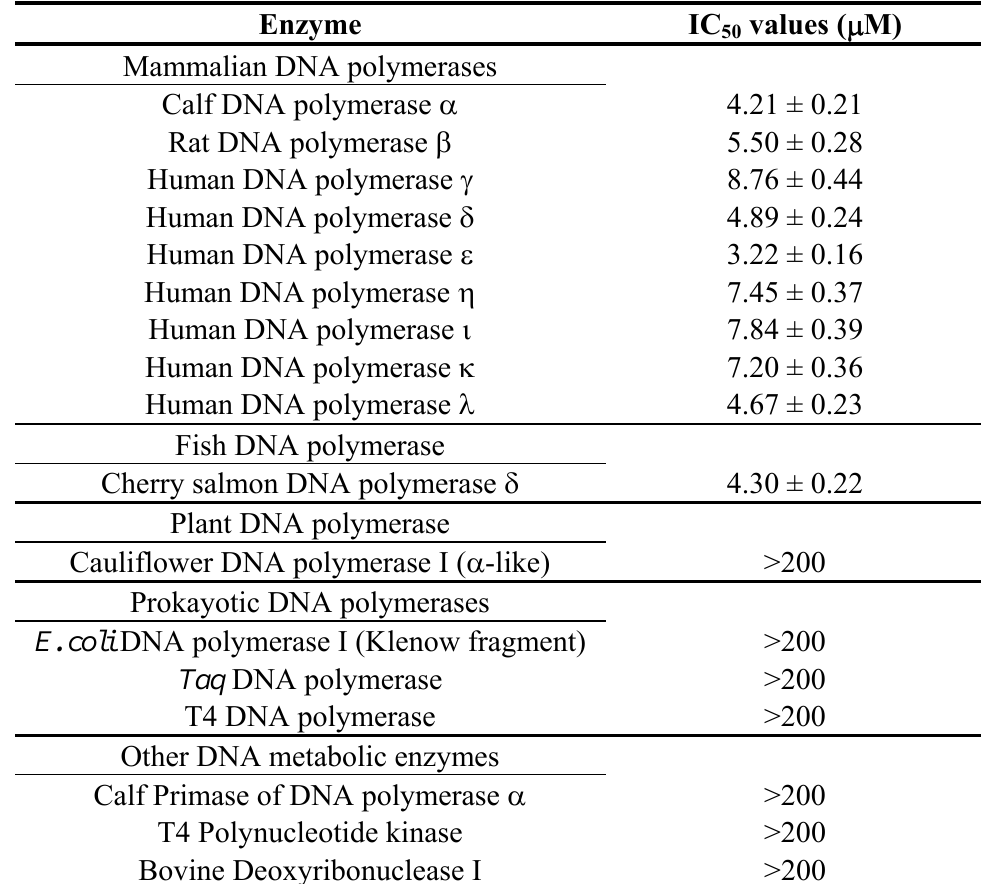
Table 1. IC values of compound 11 on the activities of various DNA polymerases and 50 other DNA metabolic